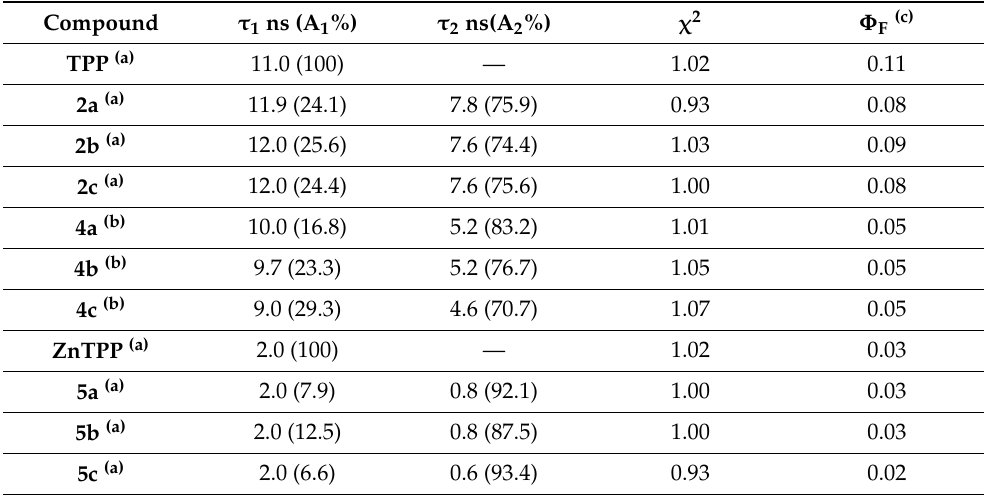
Table 2. Fluorescence lifetimes ( τ i ), respective pre-exponential factors (A i ), and fluorescence quantum yields ( Φ F ) measured for porphyrins 2 , 4 , and 5 a–c in DMF (air equilibrated samples). Compound τ 1 ns (A 1